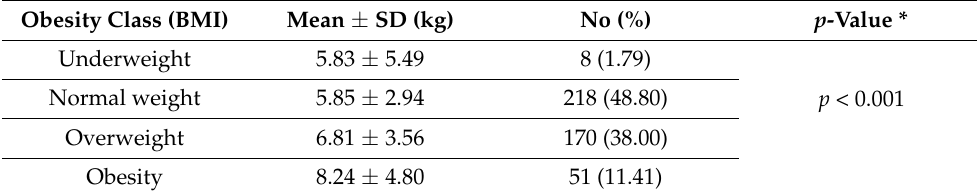
Table 2. The weight gain of the respondents depending on the BMI.